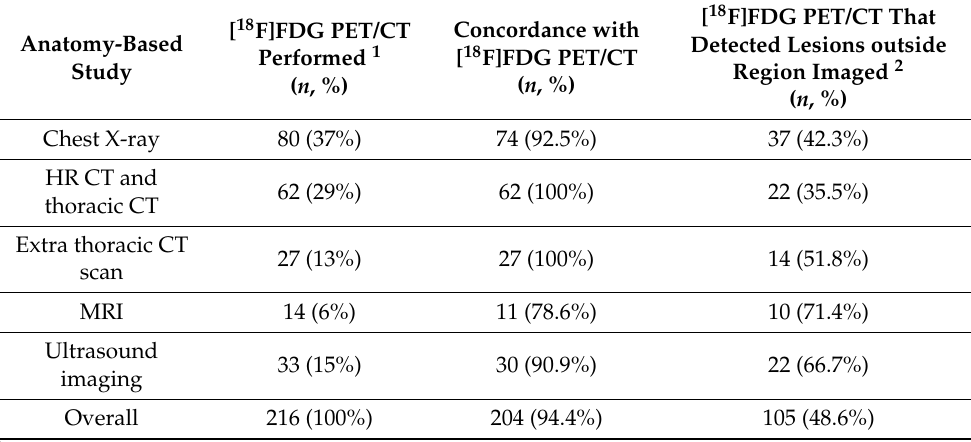
Table 4. Showing numbers of [ 18 F]FDG PET/CT studies performed for each anatomy-based study, concordance, and numbers of [ 18 F]FDG PET/CT tests that detected IFI lesions outside the regions of interest of the anatomy-based